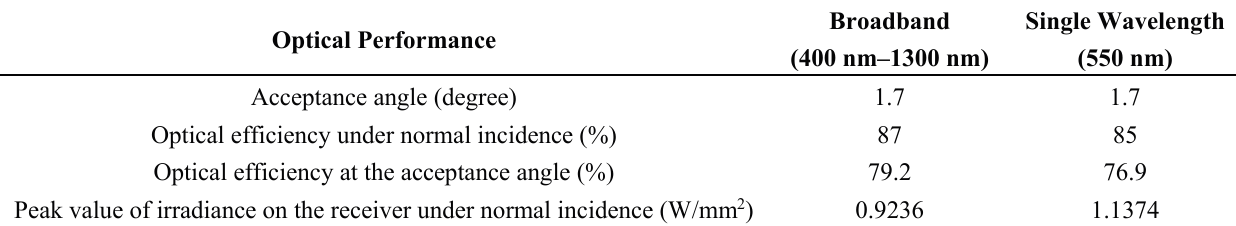
Figure 22. Optical efficiency of broadband (400 nm–1300 nm) and single wavelength (550 nm) simulation. Table 6. Comparison of optical performance of CPV unit with KOD II SOE with broadband and single-wavelength simulation.